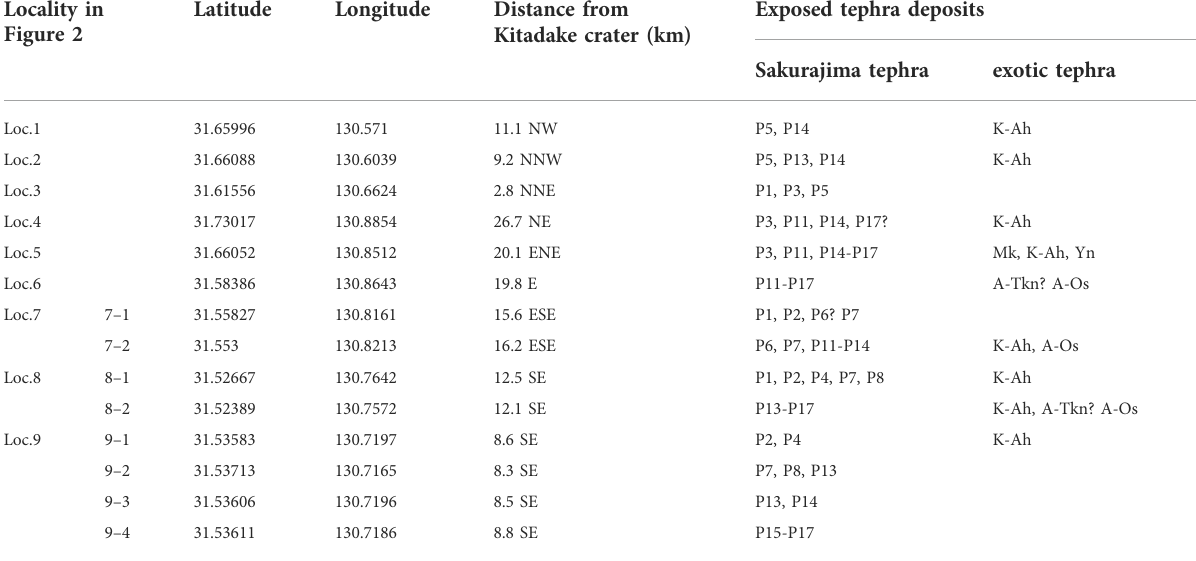
TABLE 1 Localities of the representative outcrops which can con fi rm the stratigraphic relationships of Sakurajima tephra deposits. The abbreviations of exotic tephras are the followings: Mk, Miike tephra; K-Ah, Kikai-Akahoya tephra; Yn, Yonemaru tephra; A-Tkn, Takano tephra; A-Os, Osumi pumice fall deposit which is a part of AT